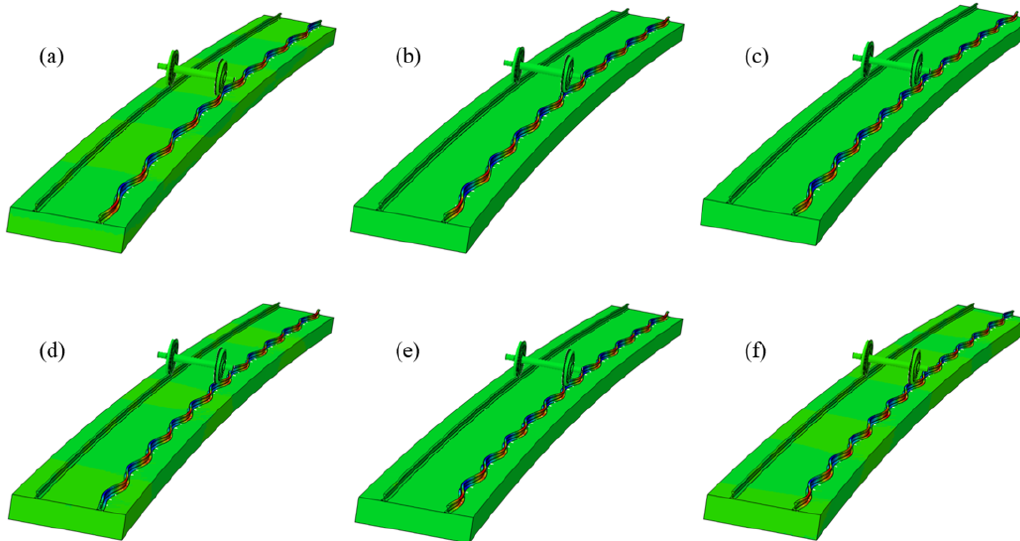
Figure 5. Dominant mode diagrams. (a) Lateral stiffness: 5, vertical stiffness: 10. (b) Lateral stiffness: 5, vertical stiffness: 20. (c) Lateral stiffness: 10, vertical stiffness: 20. (d) Lateral stiffness: 10, vertical stiffness: 30. (e) Lateral stiffness: 10, vertical stiffness: 40. (f) Lateral stiffness: 10, vertical stiffness: 50.